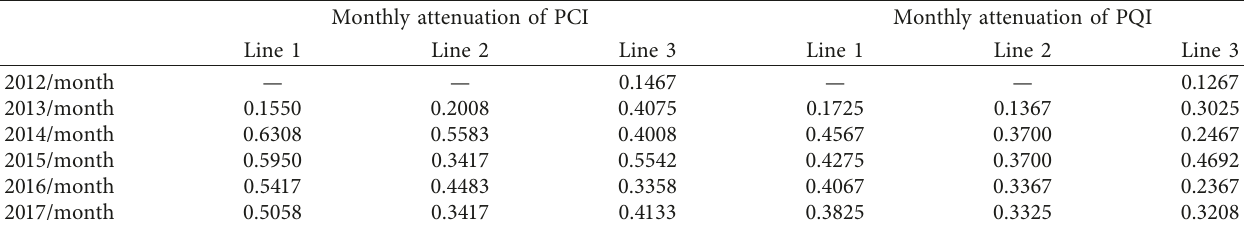
Table 5: Monthly attenuations of PCI and PQI for three typical representative lines of highways in Hunan Province.